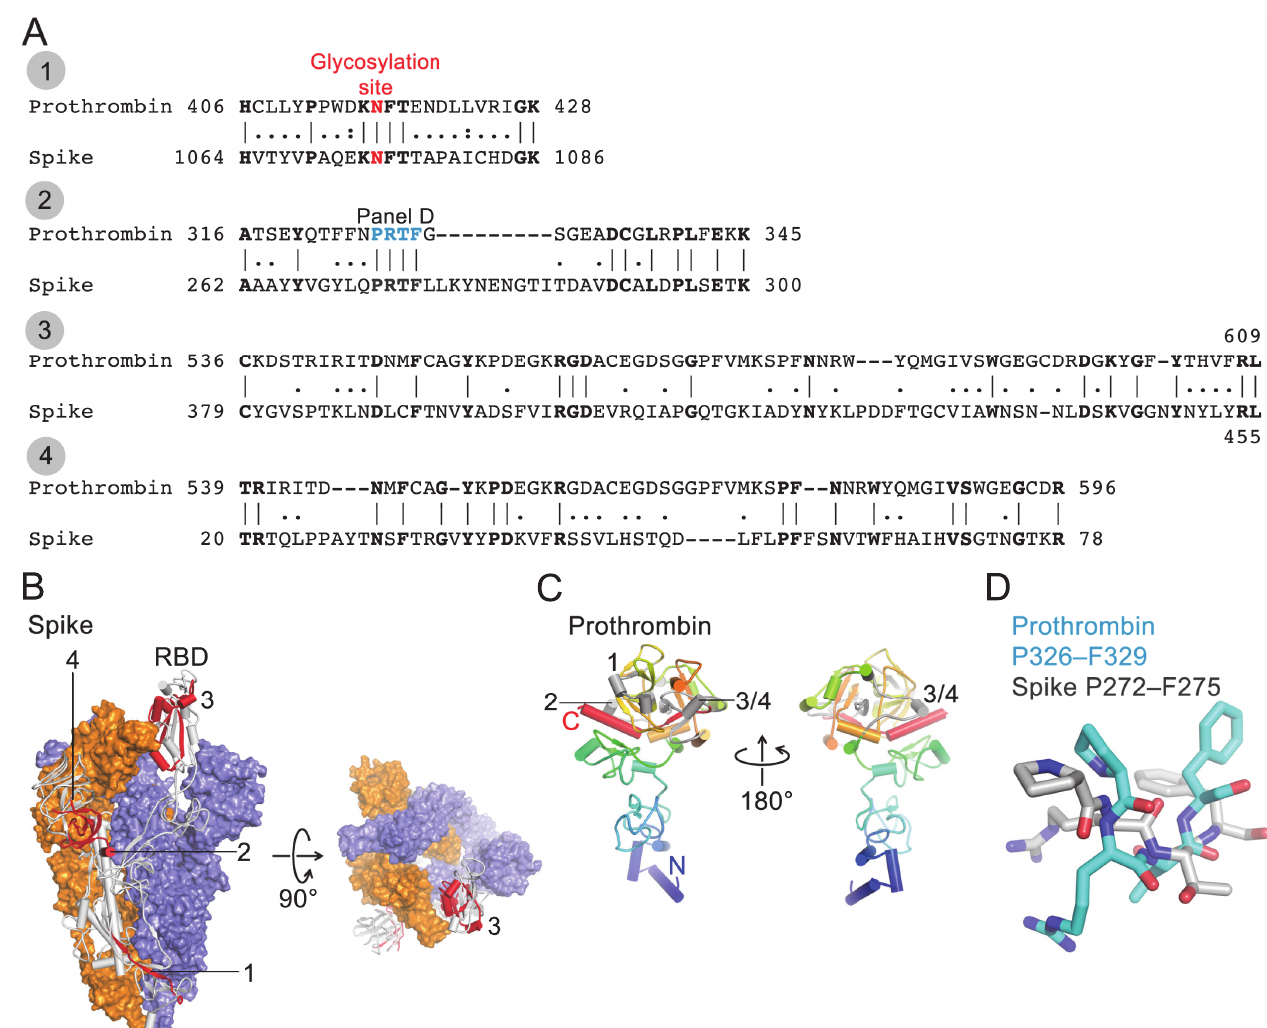
Fig 4. Sequence analysis of SARS-CoV-2 Spike and human prothrombin. A . Sequence alignments of SARS-CoV-2 Spike (numbering corresponds to UniProt ID P0DTC2) and human prothrombin (P00734). B . Cryo-EM structure of trimeric Spike (Protein Data Bank ID 6Z97 [36]). Two protomers are shown in surface representation (blue and orange) and one as a grey cartoon with 4 peptide regions shown in red and indicated. Region 3 is located in the receptor-binding domain (RBD). Glycans are not shown for clarity. C . Crystal structure of prothrombin (PDB ID 5EDM, [35]) shown as a cartoon (N- terminus, blue; C-terminus, red). 4 peptide regions are shown in grey and indicated. D . Structural superposition of the PRTF motif from Spike and